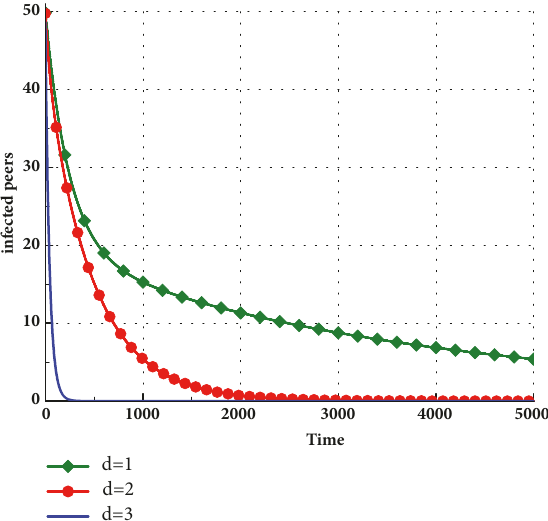
Figure 4: The impact of 𝑑 on the infected peers with 𝑅 0 = 0.8914 .